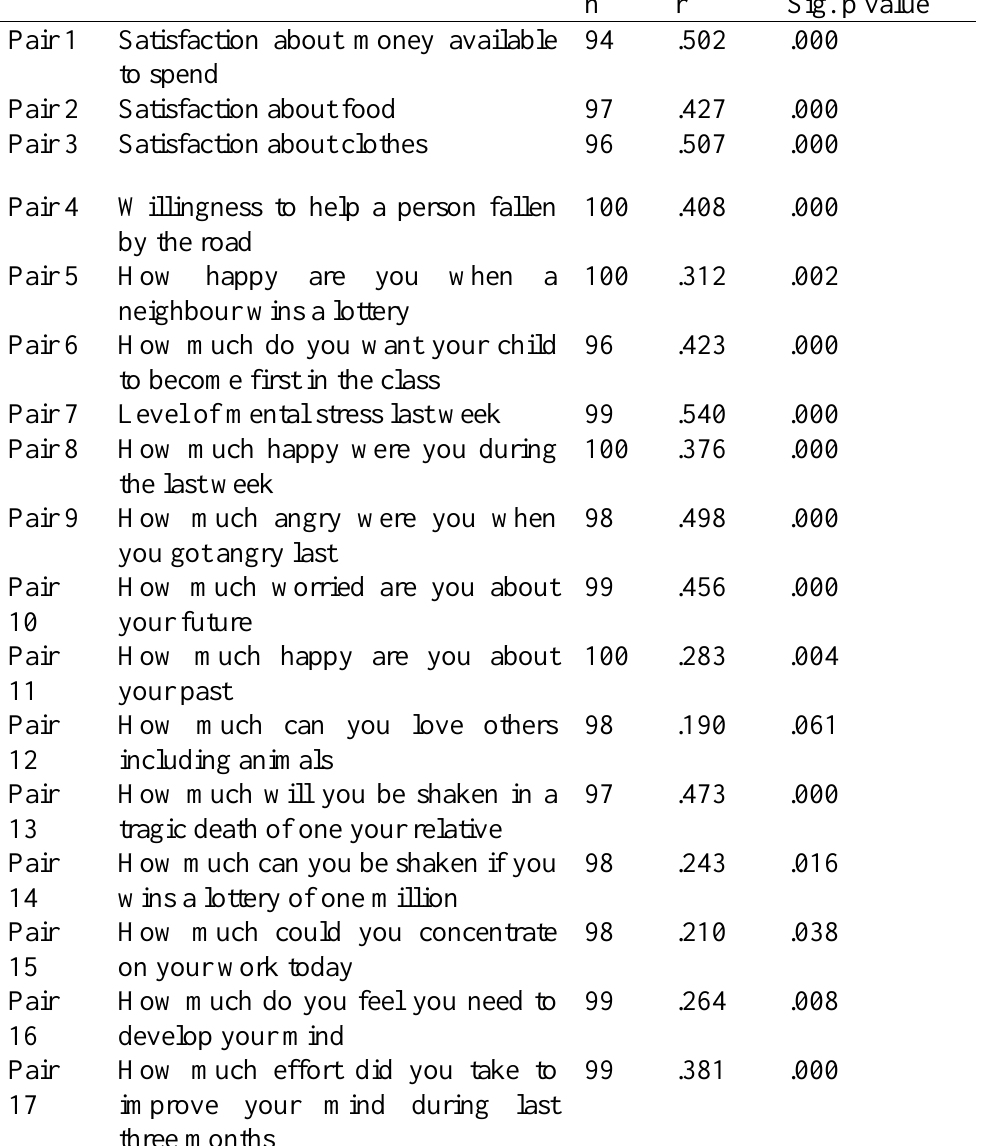
Table 1 Correlation between self assessed and interviewer assessed mental status (r= paired sample correlation